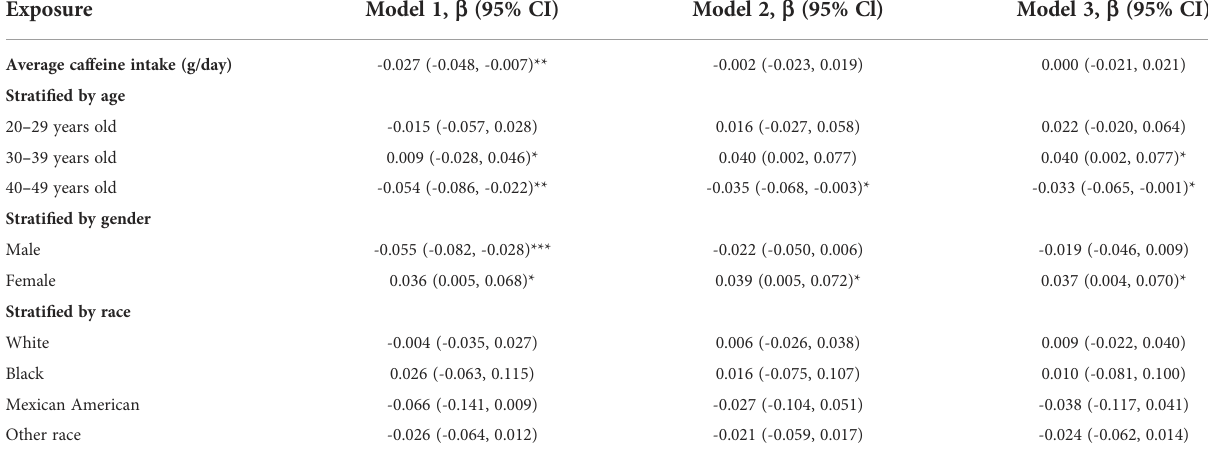
Table 2 Association between average caffeine intake (g/day) and lumbar bone mineral density (g/cm 2 ).